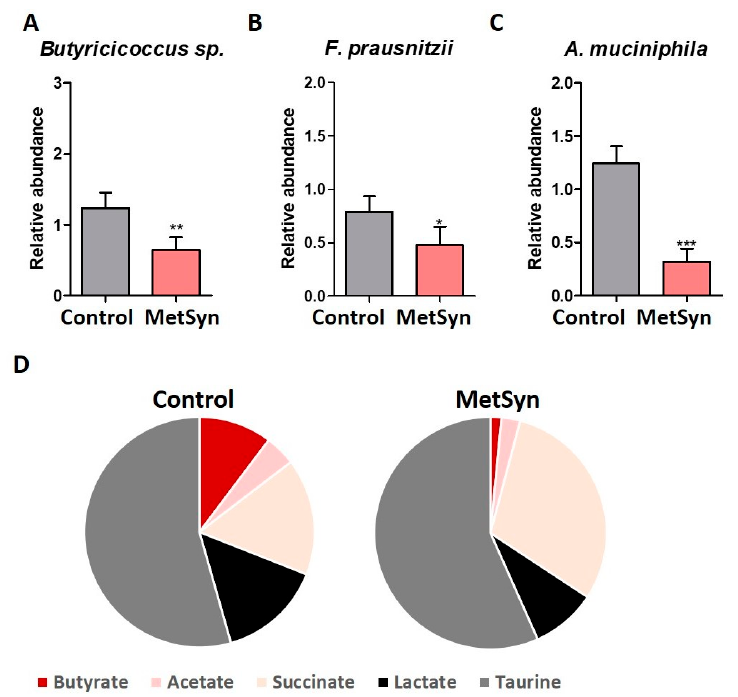
Figure 3. Microbiome-metabolome features in Met Syn. Relative abundance of Butyricicoccus sp. ( A ), F. prausnitzii ( B ), and A. muciniphila ( C ) in Met Syn patients; ( D ) Metabolite analysis in Healthy controls ( n = 30) and MetSyn patients ( n = 30); * p < 0.05, ** p < 0.005, *** p < 0.0001, Mann–Whitney test.